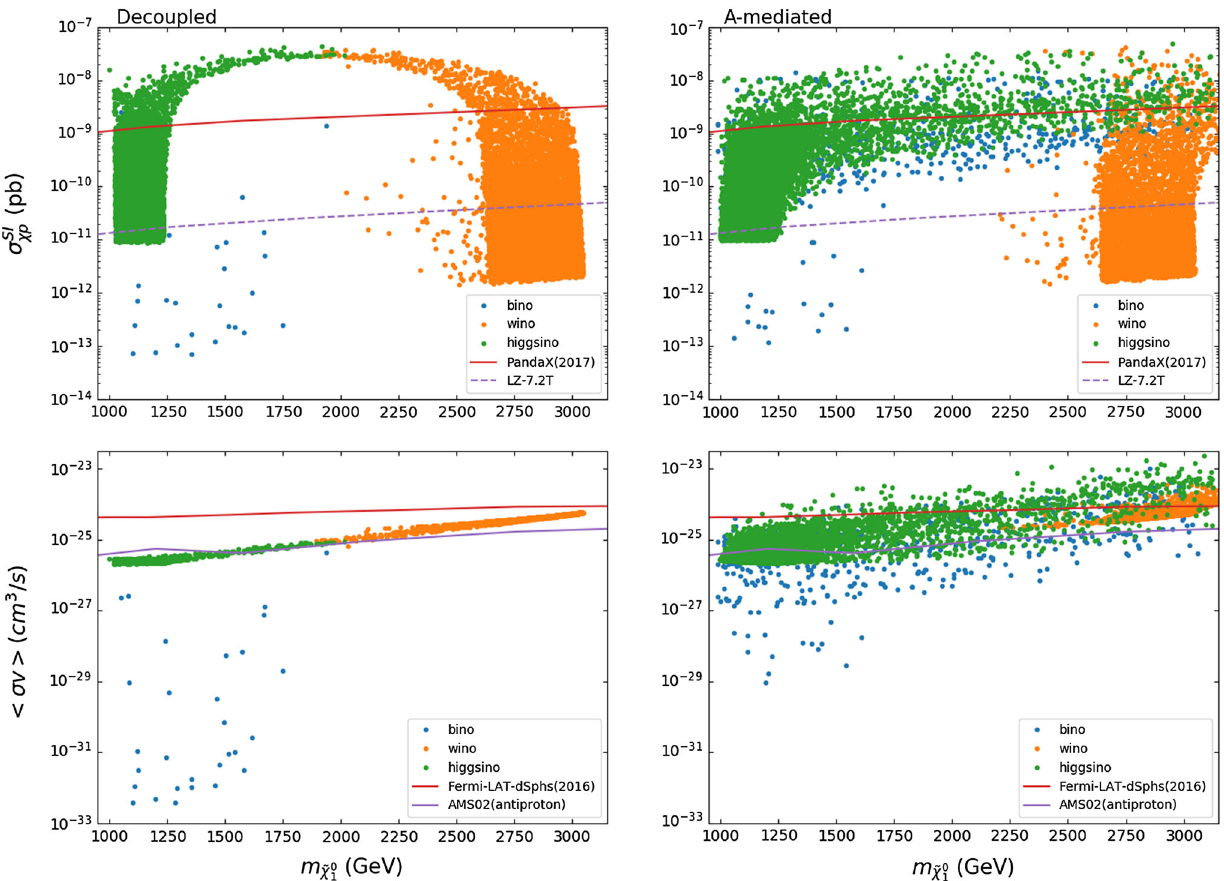
Fig. 2 Scatter plots of parameter space satisfying the relic density at 2 σ level.Theleftpanelsareforthedecoupledcasewhiletherightpanels are for the A -mediated case. The upper parts show the spin-independent neutralino LSP-nucleon scattering cross sections where the curves are the 90% CL upper limits from PandaX (2017) [1] and the future sensi-